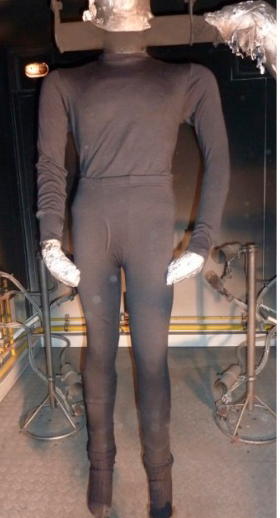
Figure 1. Tested underwear on the fire manikin.